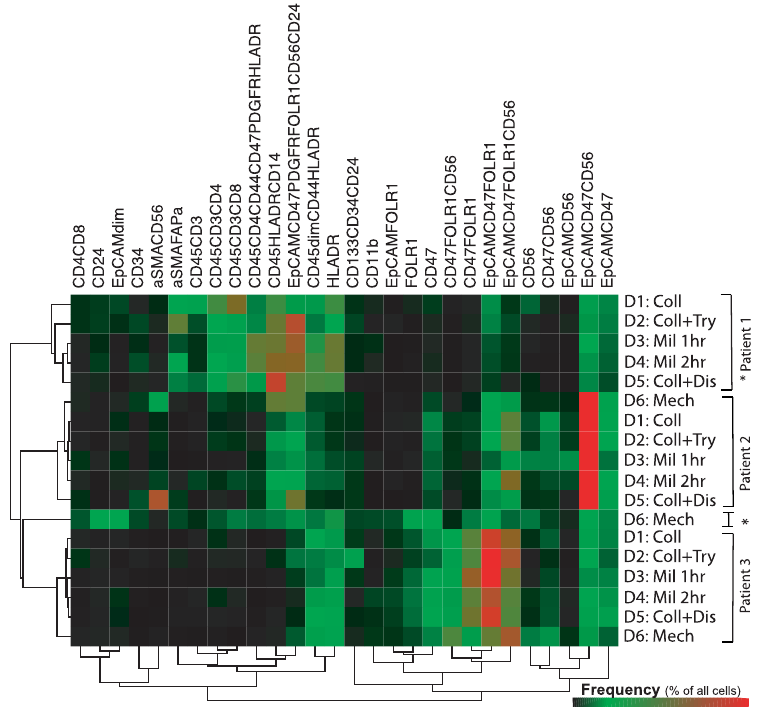
Figure 3. Hierarchically clustered heatmap showing variation in antibody expression (columns) in ovarian tissues from three patients using six different tissue dissociation methods (rows): collagenase, collagenase, and trypsin, Miltenyi enzyme mixture for 1 h, Miltenyi enzyme mixture for 2 h, collagenase and dispase, and mechanical dissociation. When the samples were clustered hierarchically according to antibody expression, the mechanically dissociated (D6) Patient 1 tumor, marked *, did separate from the rest of the samples and clustered between the samples from Patient 2 and Patient 3. The other samples cluster according to patient rather than according to dissociation method applied to the tissue.